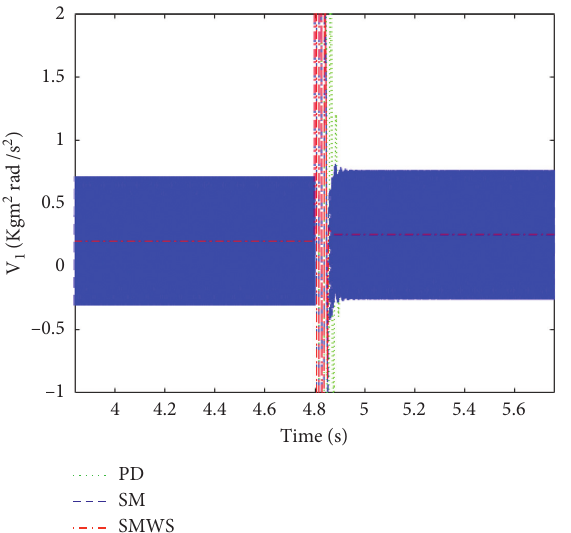
Figure 10: A zoom in the fictitious input of the second electricity generator.